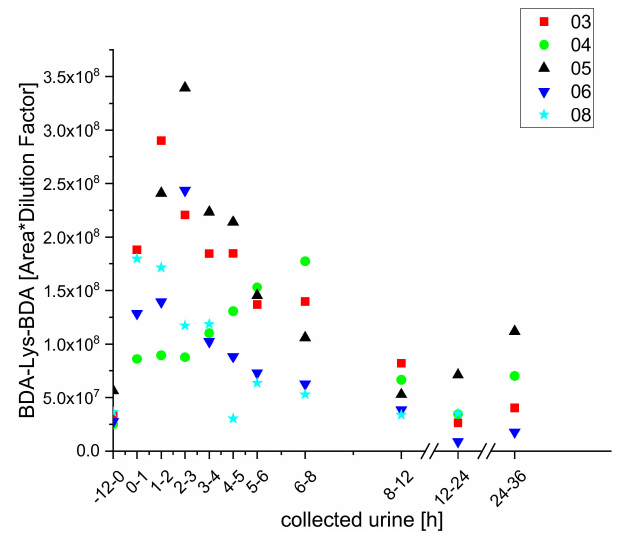
Figure 9. Excretion kinetics of BDA-Lys-BDA: UPLC-qToF-MS / MS measurements of contents in samples of urine from participants three, four, five, six, and eight at indicated times after co ff ee consumption (h). Based on our findings regarding metabolites detected by the UPLC-qToF-MS / MS approach in co ff ee brew shown in Figure